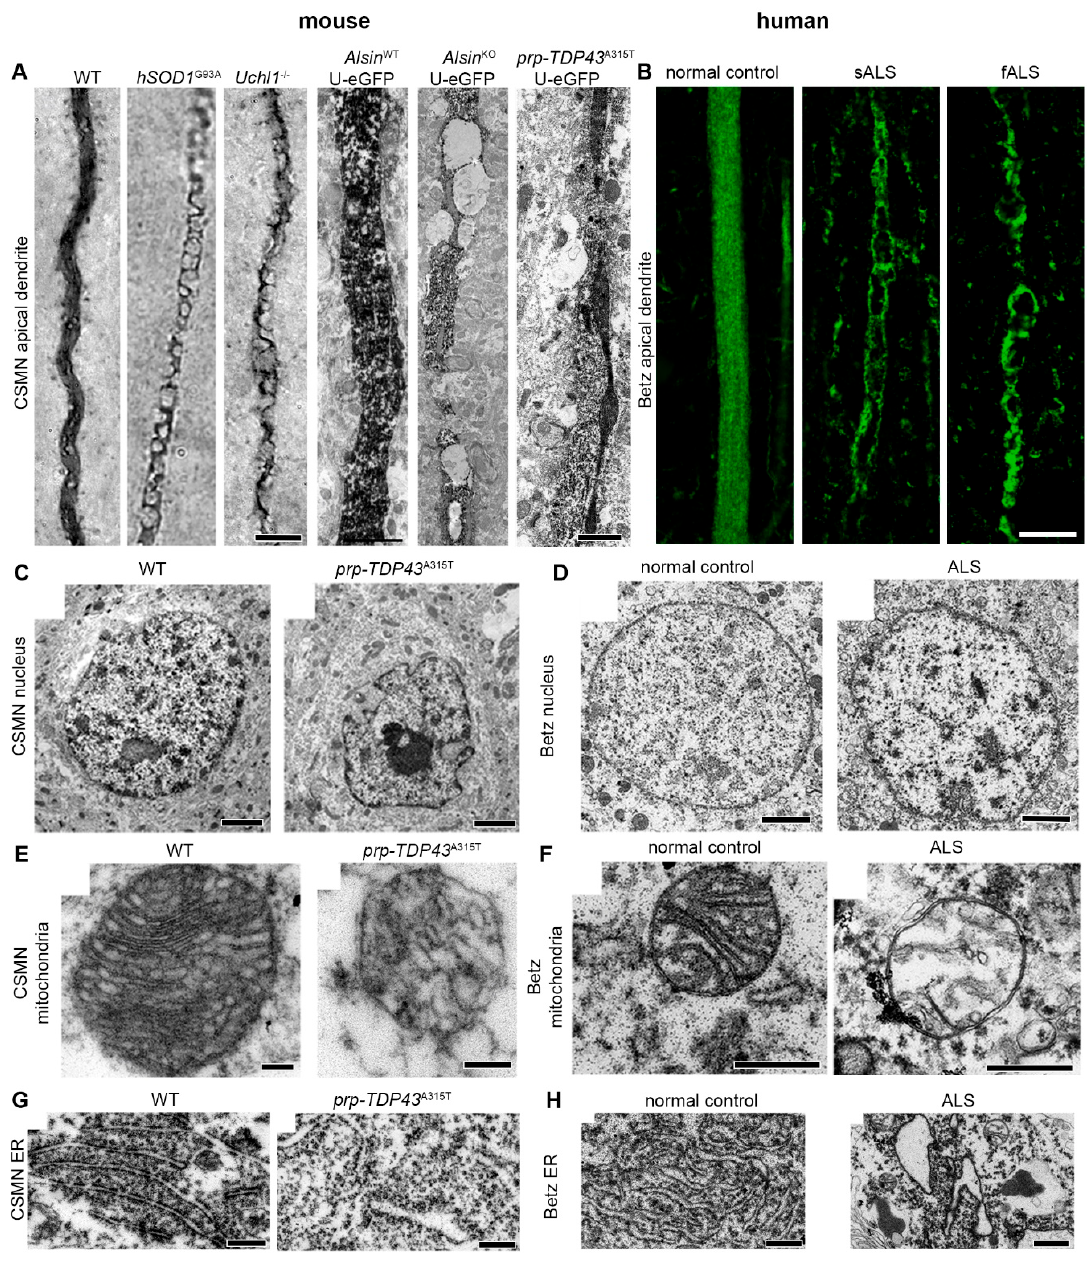
Figure 2. Betz cell pathology is similar between mouse and human at a cellular level. ( A ) Apical dendrites of CSMN displaying vacuoles in brains of various mouse models of motor neuron disease. ( B ) Apical dendrites of Betz cells displaying vacuoles in brains of patients with sporadic or familial ALS. ( C – H ) Electron microscope images showing pathology of various organelles in CSMN of prp - TDP43 A315T mouse and Betz cells of ALS patients. Observe similar nuclear membrane defects ( C , D ), mitochondria defects ( E , F ), and endoplasmic reticulum defects ( G , H ). Scale bars: 5 µ m (brightfield, left), and 1 µ m (E.M., right) in (A), 10 µ m in (B), 2 µ m in (C), 500 nm in (D), 200 nm in (E), 500 nm in (F), 1 µ m in (G–H).